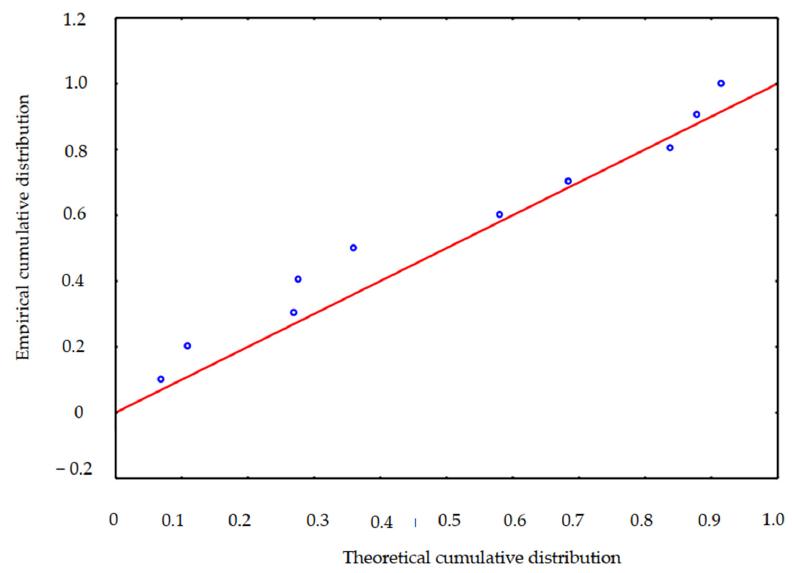
Figure 11. Plot of observed values (empirical cumulative distribution) versus expected frequencies (theoretical cumulative distribution).